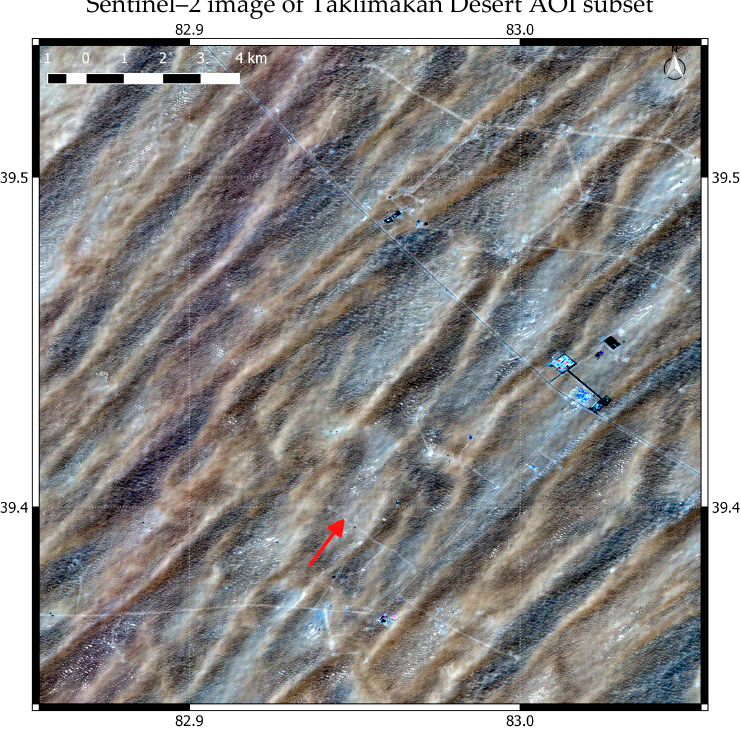
Figure 19. Sentinel–2 image of the same area as in Figure 17. The image was acquired on 31 July 2019 (roughly in the middle of the Sentinel–1 time series). It is displayed in true colour, bands 4,3,2 as red, green, and blue, respectively. Contains modified Copernicus Sentinel data 2020.